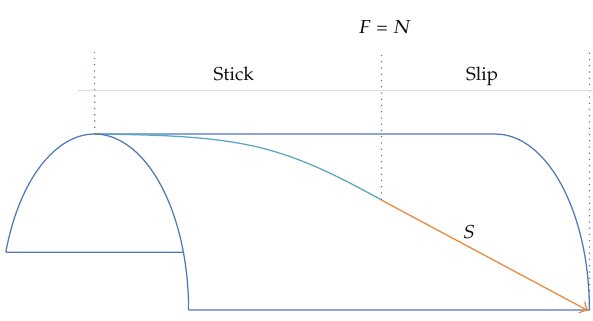
Figure 8: Slip progression from neutral